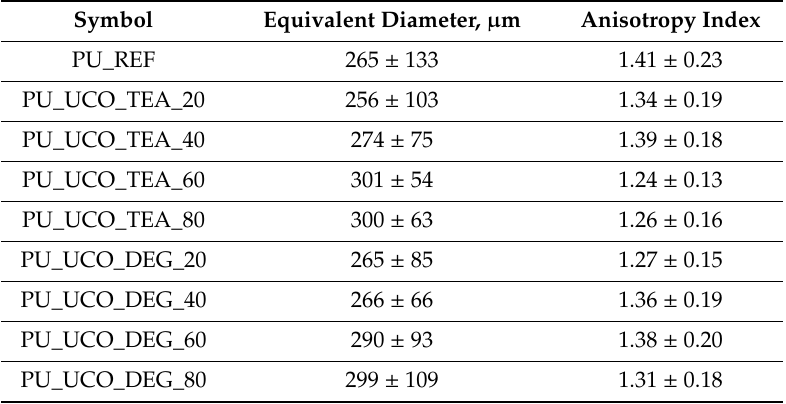
Table 3. Characteristic properties of cellular structure of PUR foams.